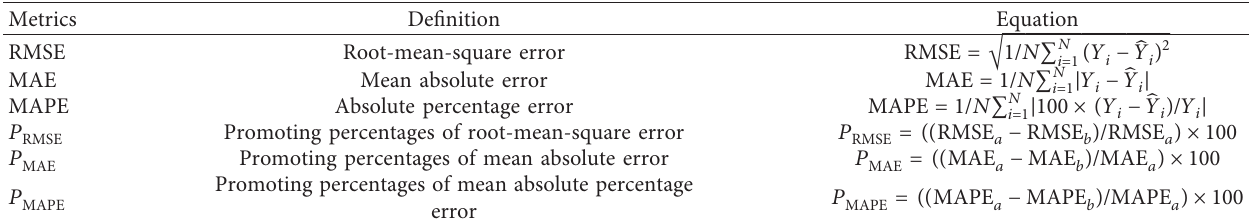
Figure 4: Coding strategy of the population in the proposed model based on AMGWO. Table 2: Six metrics employed for quantitative evaluation of the proposed